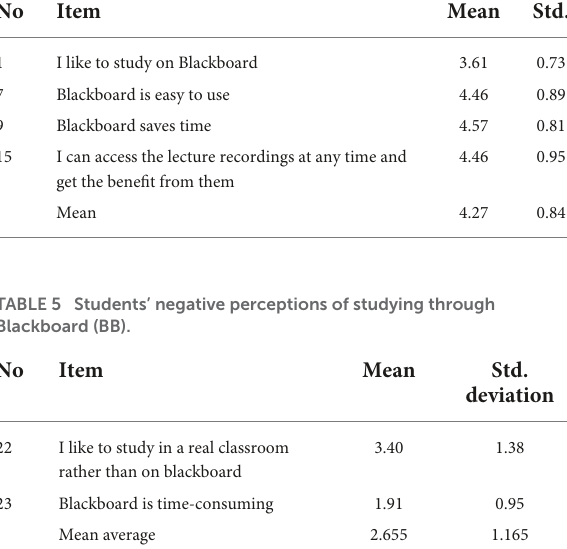
TABLE 4 Students’ positive perceptions of studying through Blackboard (BB).